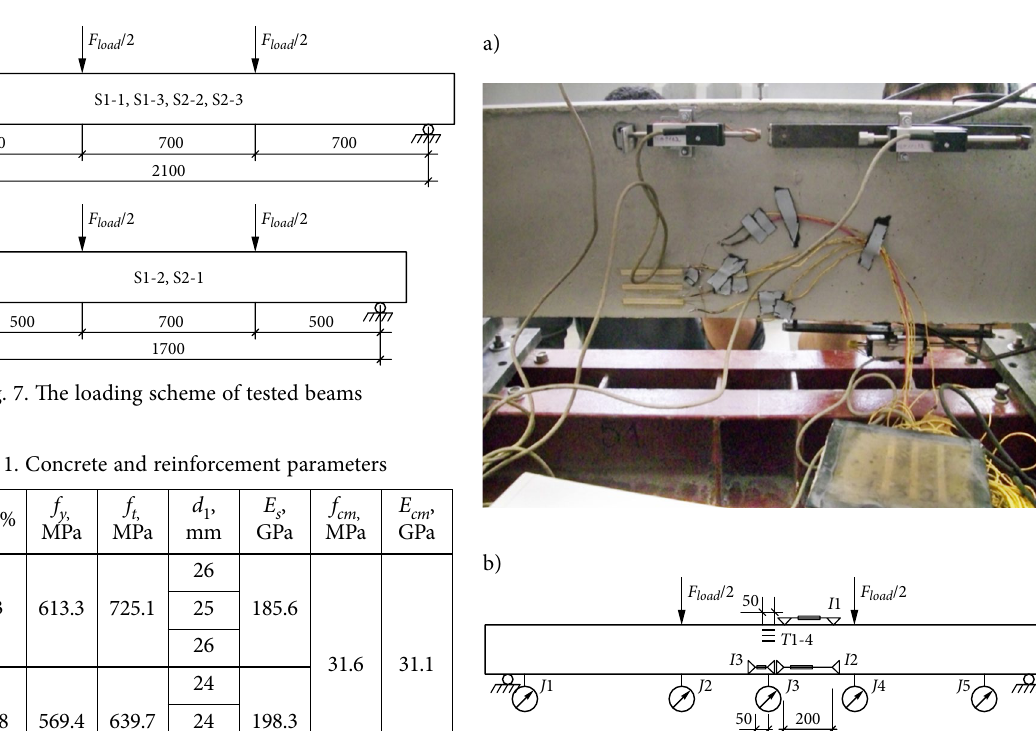
Fig. 6. The reinforcement layout of tested beams